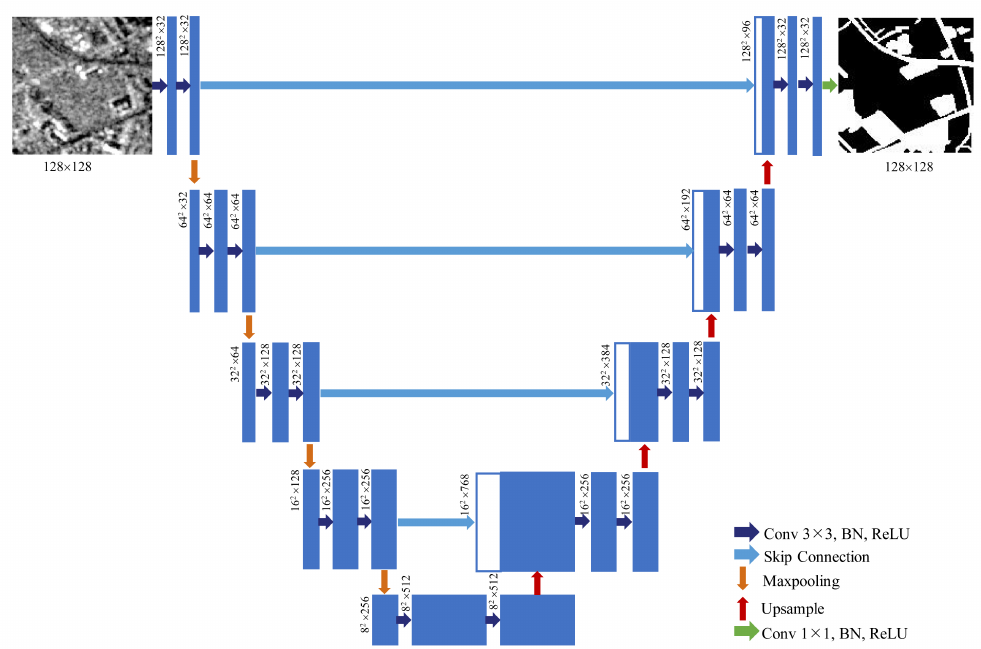
Figure 3. The basic structure of UNet